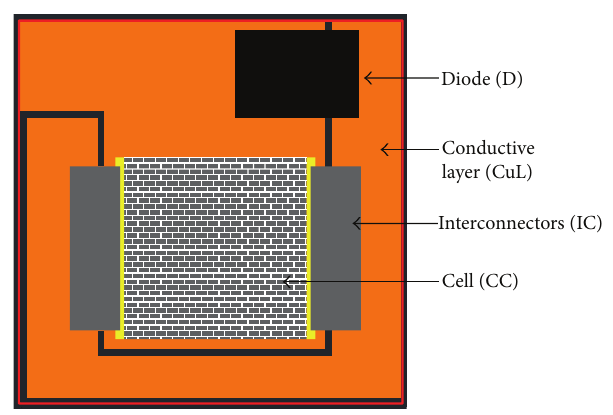
Figure 13: Components distribution across the 21mm × 21mm surface, delimited by the red